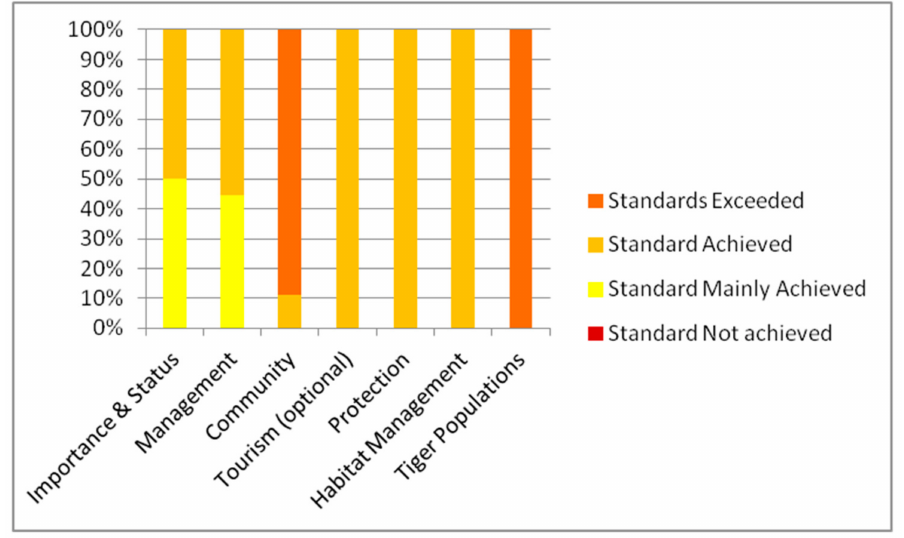
Figure 5. Overview of conformity of the 17 elements under seven pillars of CA|TS (see Figure 2) of CA|TS for Sikhote-Alin Nature